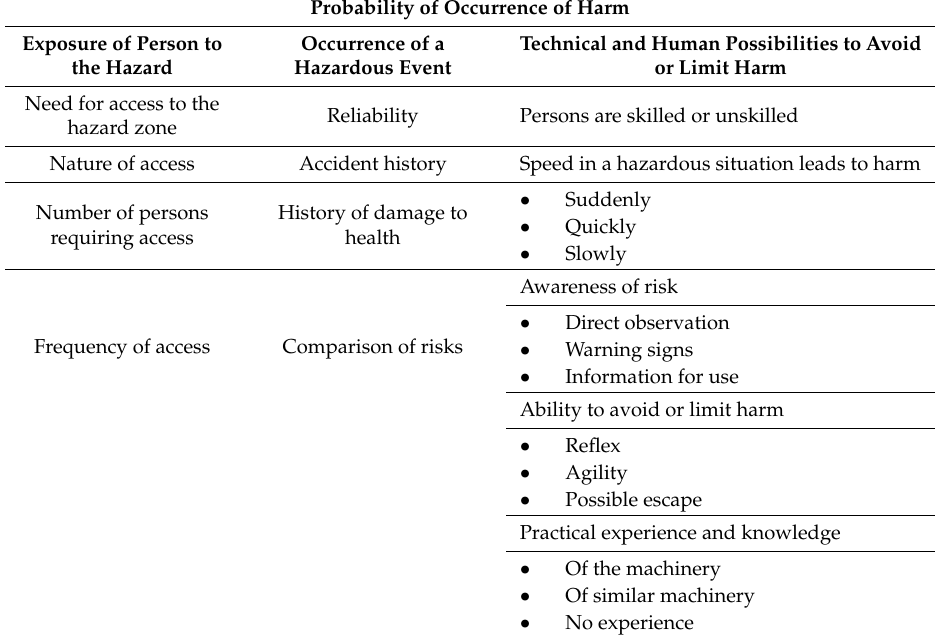
Table 3. Factors a ff ecting the three parameters defining the probability of occurrence of harm based on ISO 12100.